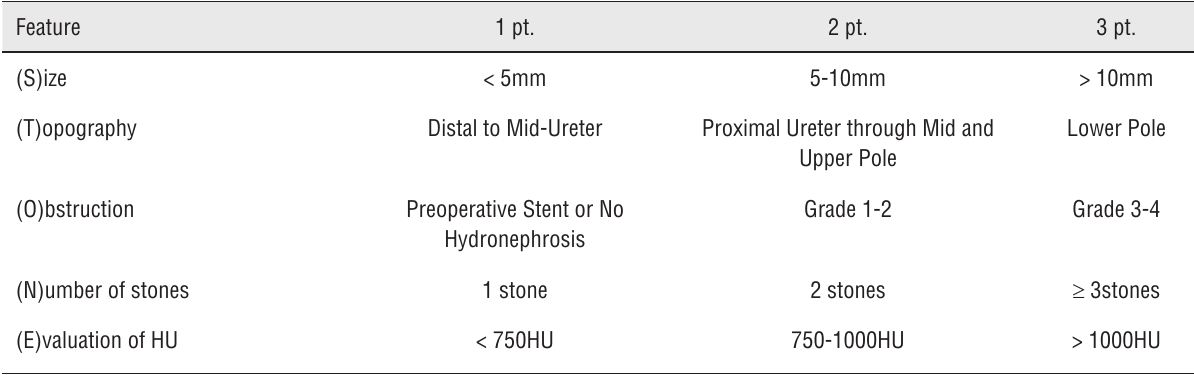
Table 1 - S.T.O.N.E.